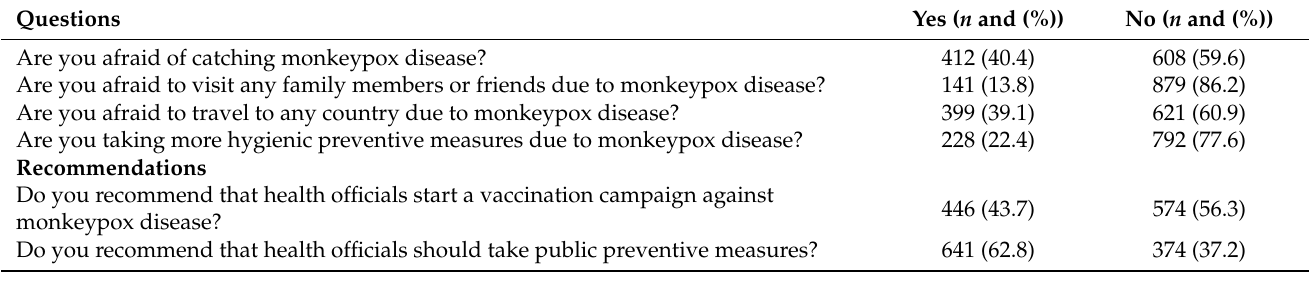
Table 4. Preventive and recommended measures against monkeypox disease.